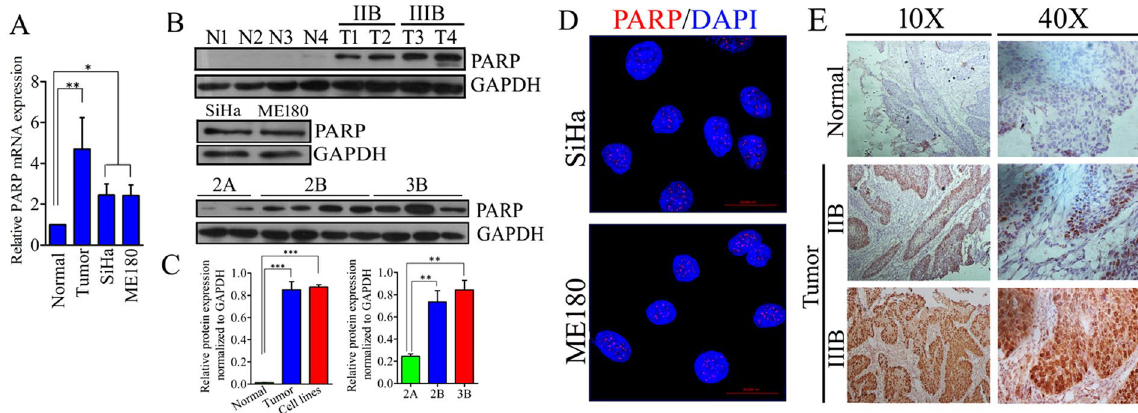
Figure 1. Expression of PARP1 in primary tissue samples and CC cell lines; ( A ) Bar graph displaying quantitative mRNA expression of PARP1 in normal samples (n = 15) and tumor samples (35) along with two cervical cancer cell lines SiHa and ME180. (normal vs . tumor ** p = 0.0035, normal vs . cell lines * p = 0.0359, tumor vs . cell lines p = 0.3993. ( B ) Western blots displaying expression of PARP1 protein in normal and tumor samples as well as in CC cell lines.The full size blots corresponding to the cropped blot images are given in Supplementary Figure S12. ( C ) Bar graph showing relative quantification of protein expression normalized to GAPDH. ( D ) Representative immunofluorescence image showing nuclear localization of PARP1 as foci in SiHa and ME180 cell lines. ( E ) Representative image showing nuclear PARP1 expression in tumor samples from CC patient. Normal samples do not show any nuclear staining. However, IIIB samples have greater staining intensity than